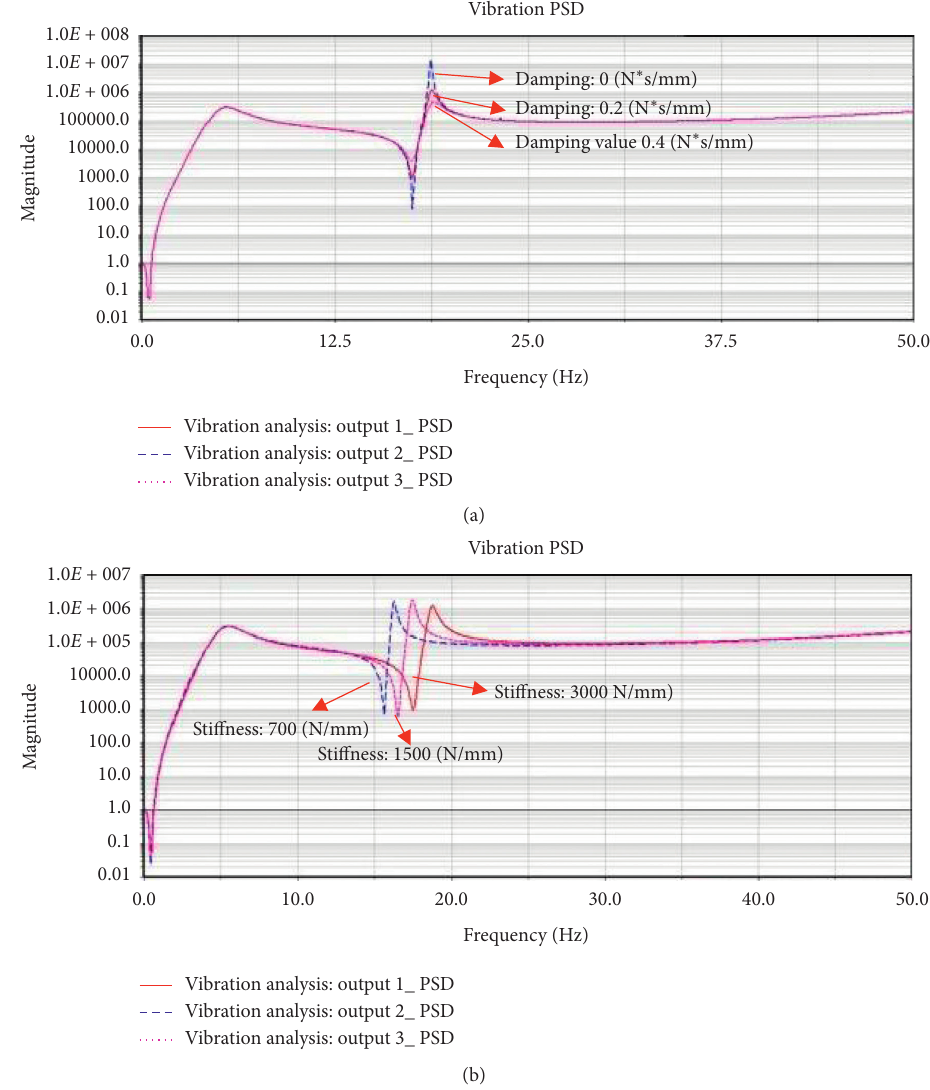
Figure 14: Effect of stiffness and damping of front suspension of the cab on PSD. (a) PSD curve of cab centroid acceleration under damping fine adjustment. (b) PSD curve of cab centroid acceleration under stiffness fine-tuning.